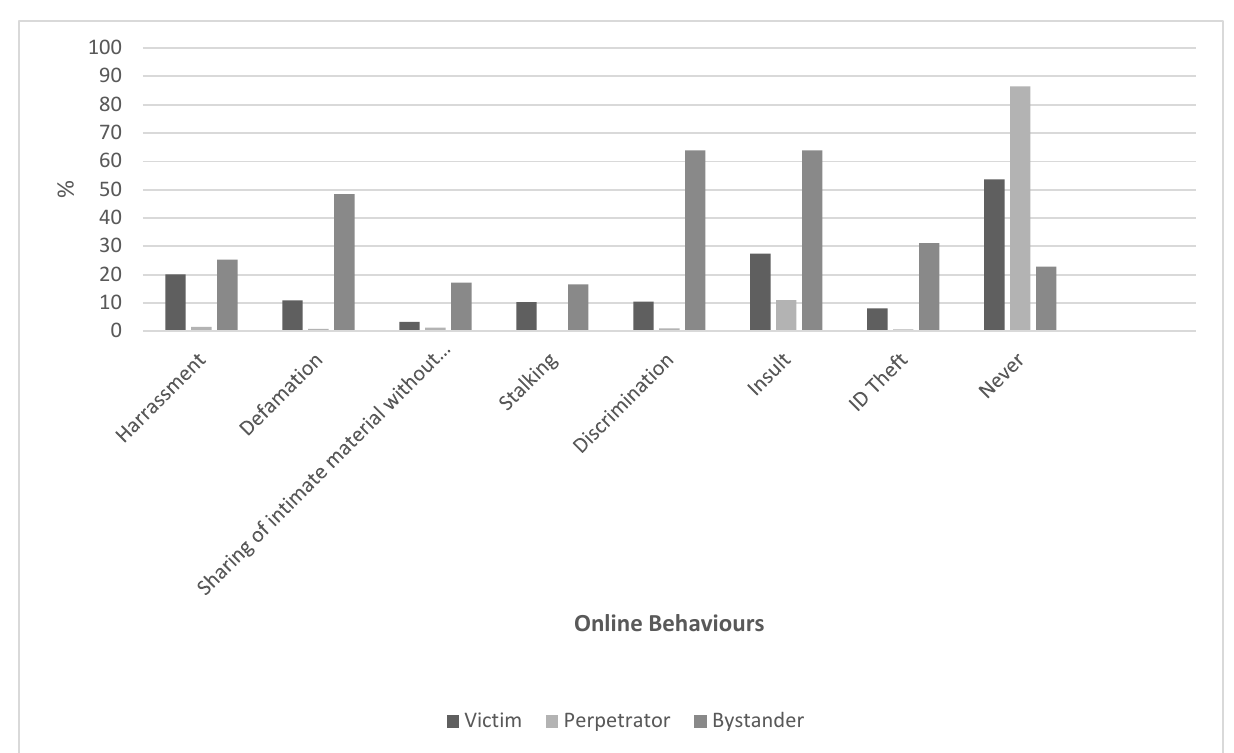
Figure 1. Frequency of aggressive online behaviors described stratifying by role (victim, perpetrator, and bystander).